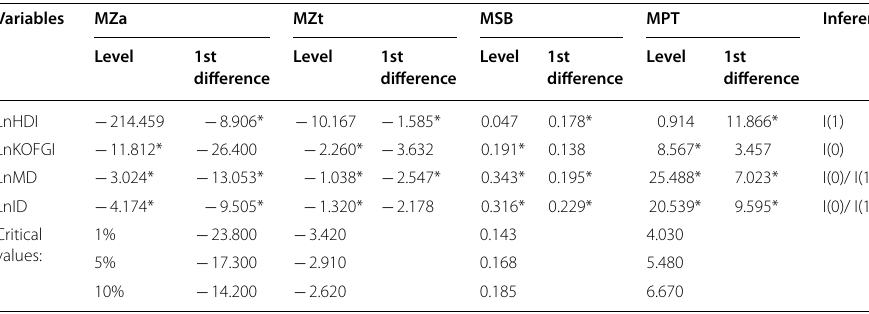
Table 5 Ng–Perron test results